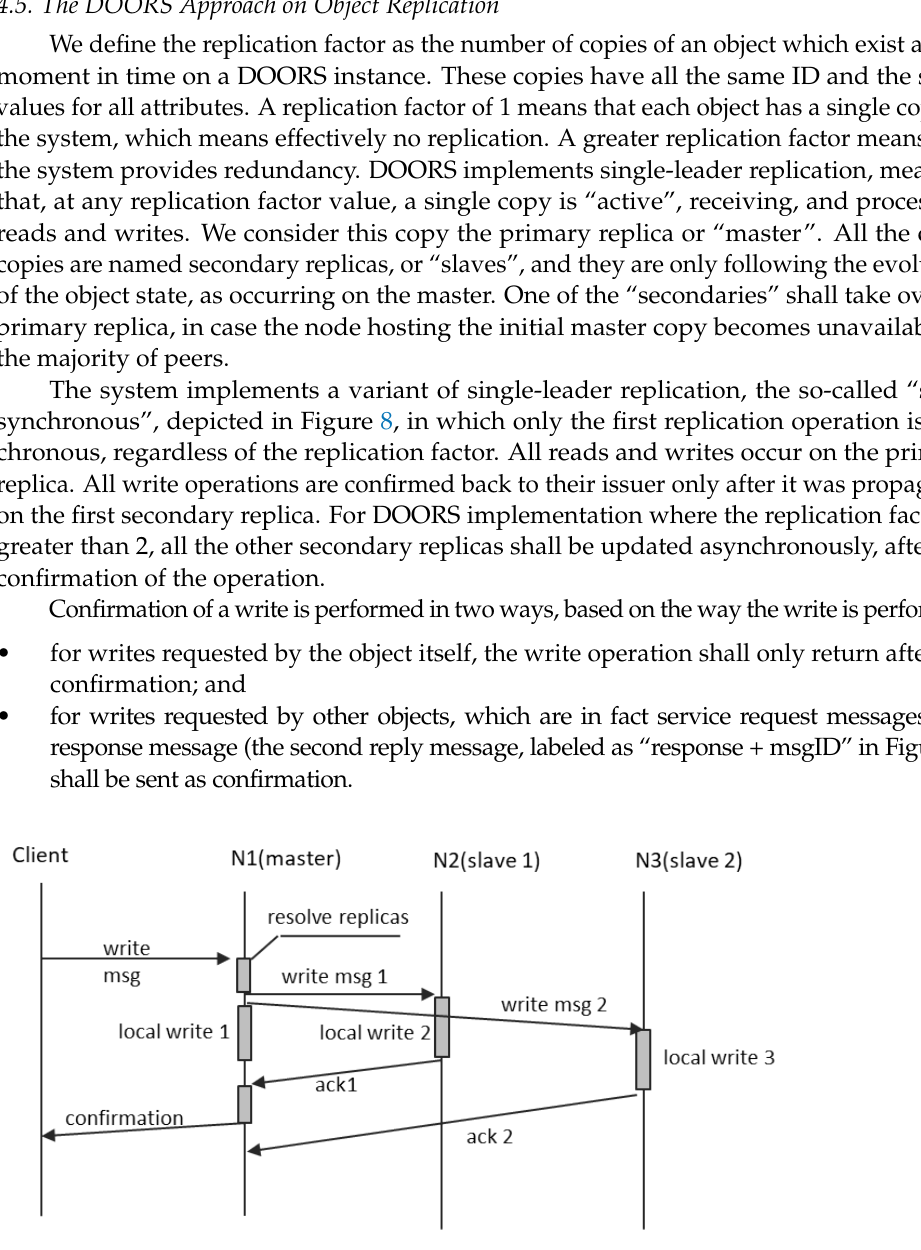
Figure 8. Semi-synchronous